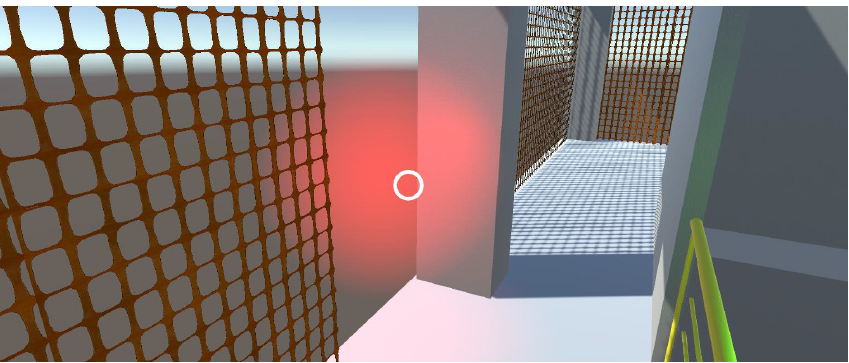
Figure 8. Recreation of a risk due to a defect in the maintenance and supervision of safety nets (CPE).